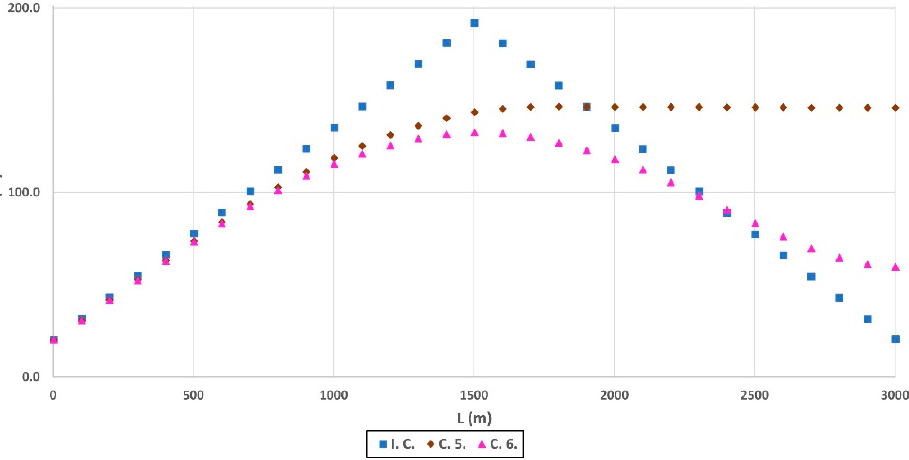
Figure 10. Fluid temperature inside the exchanger: I.C. initial condition (blue), C.5. (coffee), C.6. (pink).